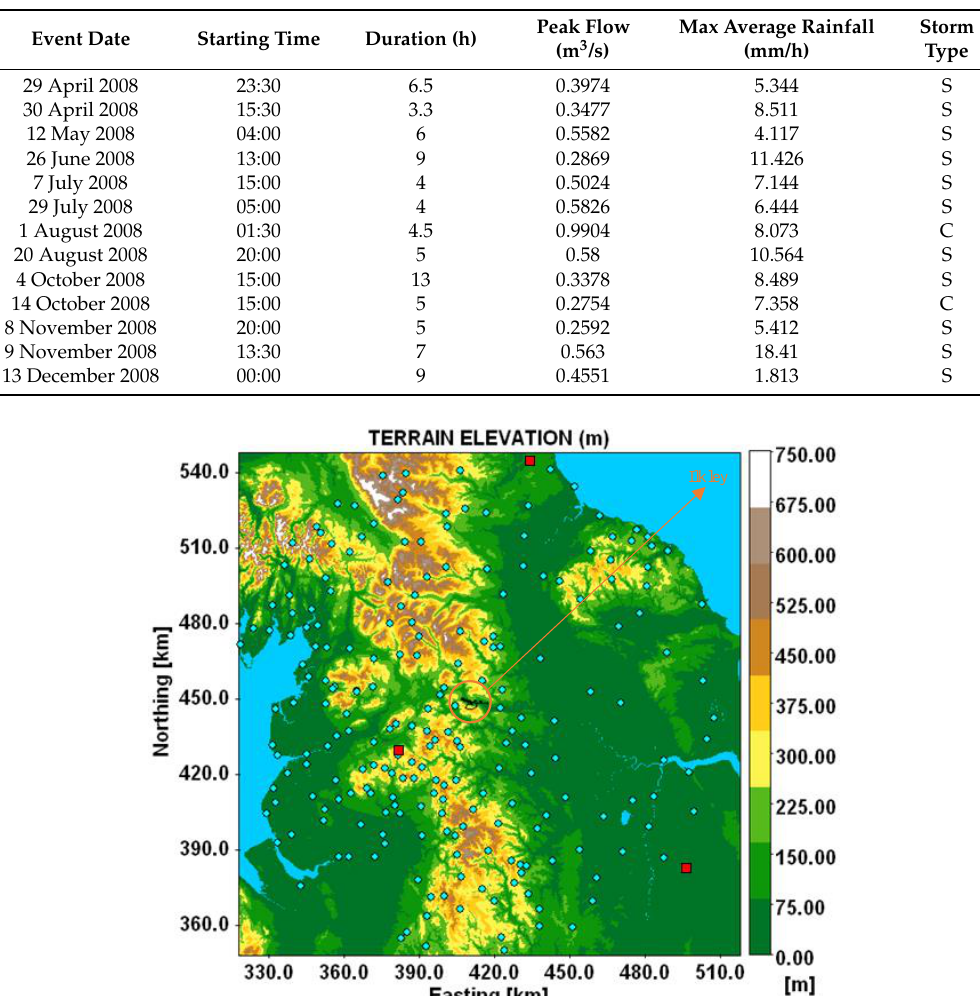
Table 1. Event start dates, duration, peak measured flow, maximum average rainfall and storm types (S — stratiform and C — convective) for the Ilkley urban catchment.